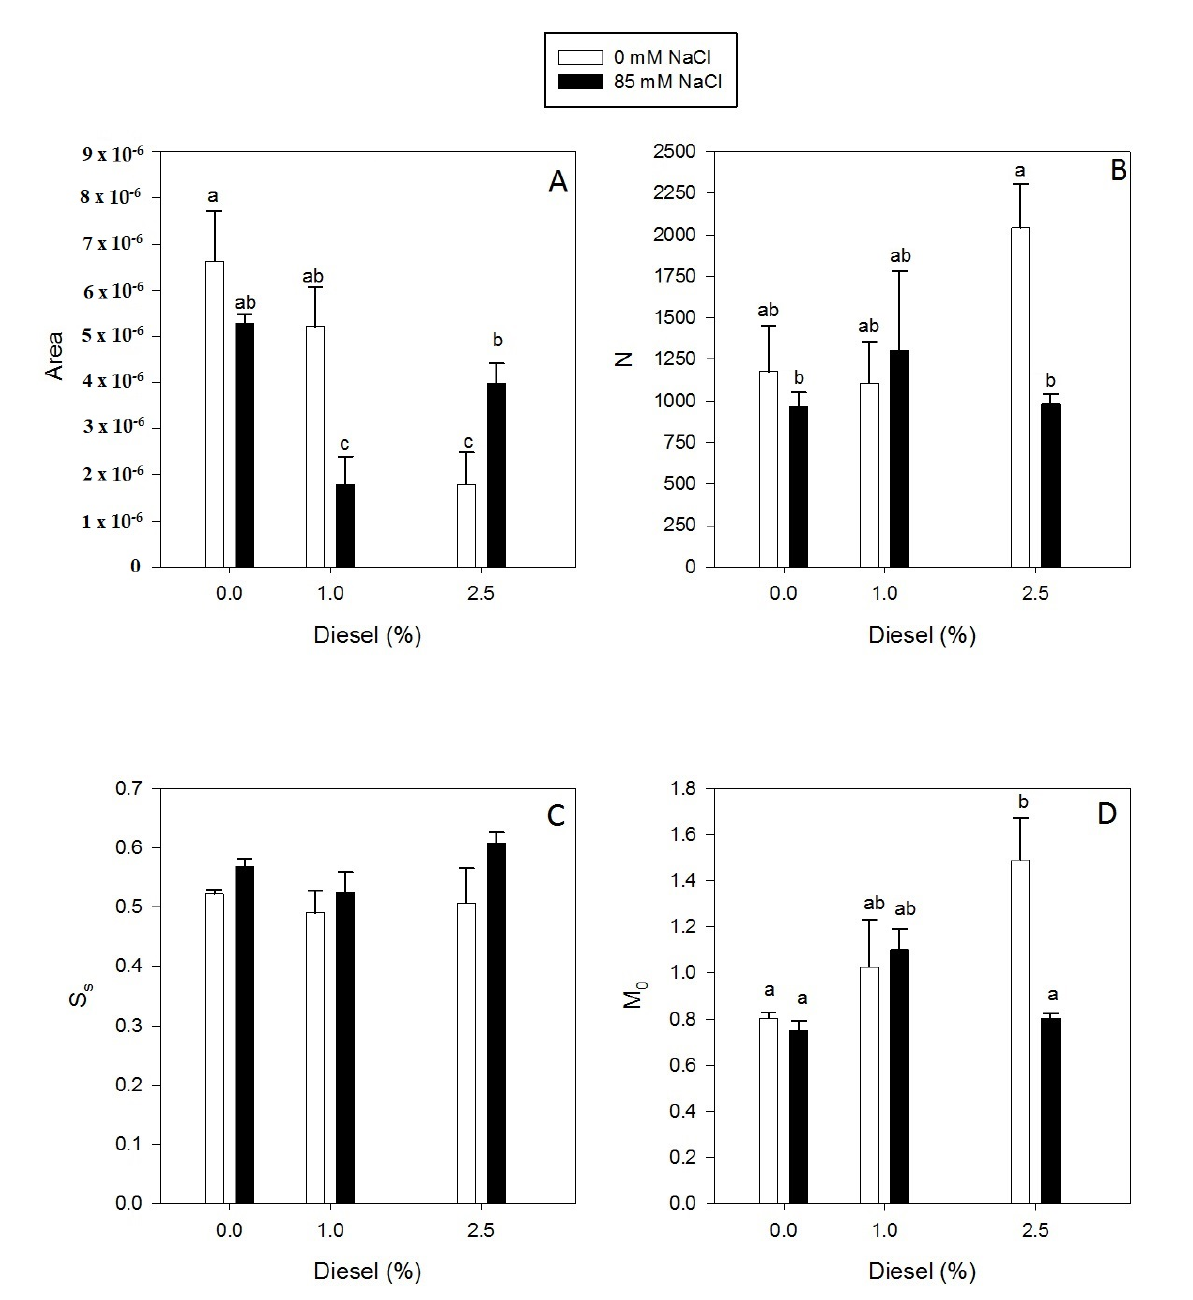
Figure 5. Oxidized quinone pool size available for reduction, Area ( A ), Reaction centre turnover rate, N ( B ), relative pool size of plastoquinone, S S ( C ) and net rate of PS II RC closure, M 0 ( D ) in dark-adapted randomly selected, primary branches of Juncus acutus in response to treatment with a range of diesel concentrations at 0 and 85.5 mM NaCl for 20 d. Values represent mean ± SE, n = 5. Different letters indicate means that are significantly different from each other (LSD, p <